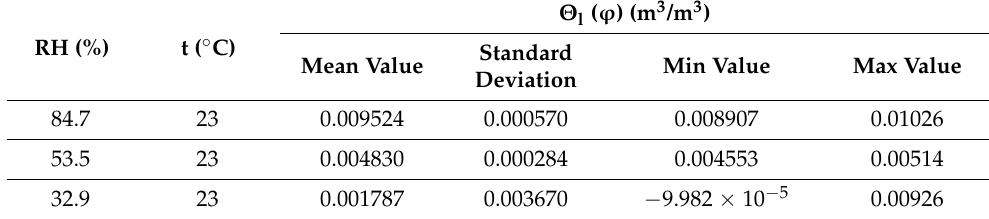
Table 8. Sorption moisture